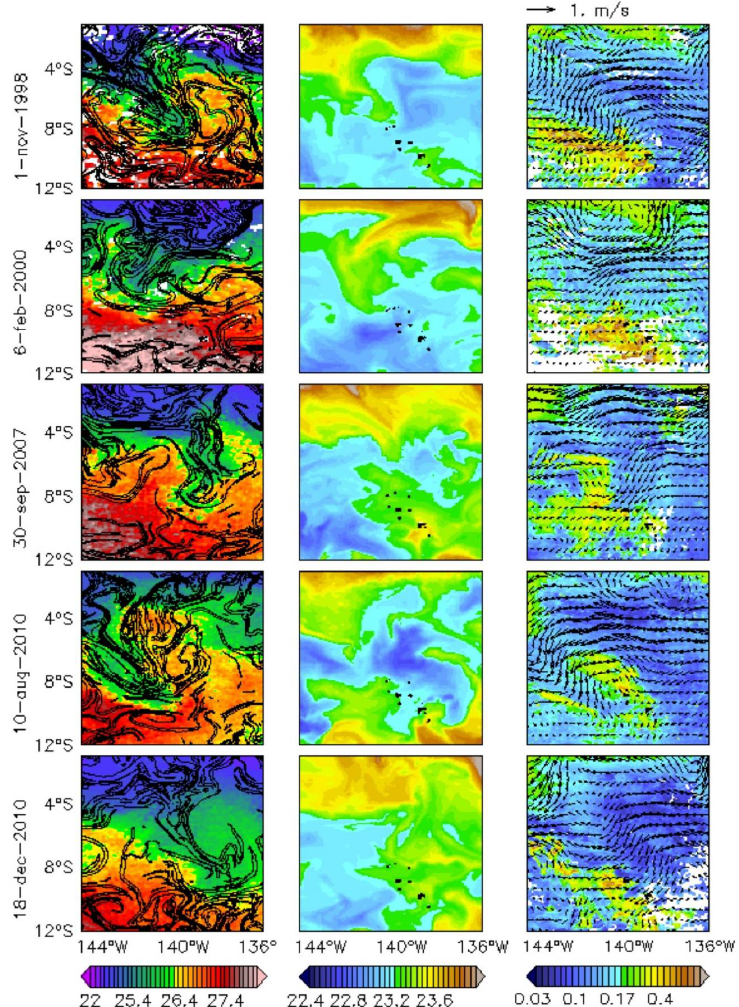
Figure 7. ( Left ) SST (°C) and FSLEs (d −1 , isocontours are plotted from 0.07 to 1 every 0.1); ( Centre ) surface sigma (kg/m 3 ); ( Right ) Chl (mg/m 3 ) and surface current (m/s) during the five moderate to strong La Niña events over 1997–2014 (top to bottom). The islands are shown in black.